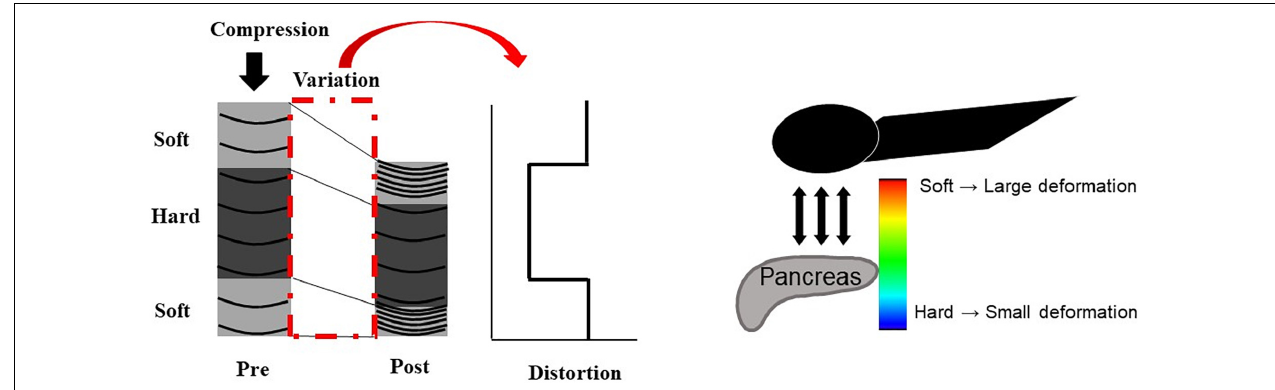
FIGURE 2 | Illustration of EUS strain elastography. The strain created by compression of the target tissue with the EUS probe or cardiovascular pulsation through the aorta is expressed on ultrasound images. A larger strain indicates softer tissue, whereas a smaller strain reflects harder tissue. Strain is exhibited via different colors based on the elasticity of the tissue: red indicates soft tissues, and blue indicates hard tissues.